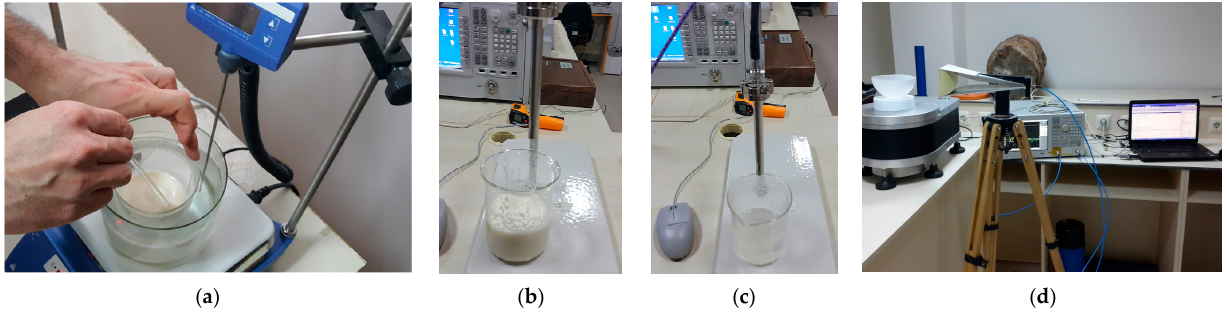
Figure 2. ( a ) Fantom fabrication, dielectric constant measurement of ( b ) healthy and ( c ) tumor phantoms and ( d ) microwave measurement setup for two-dimensional breast tumor imaging.